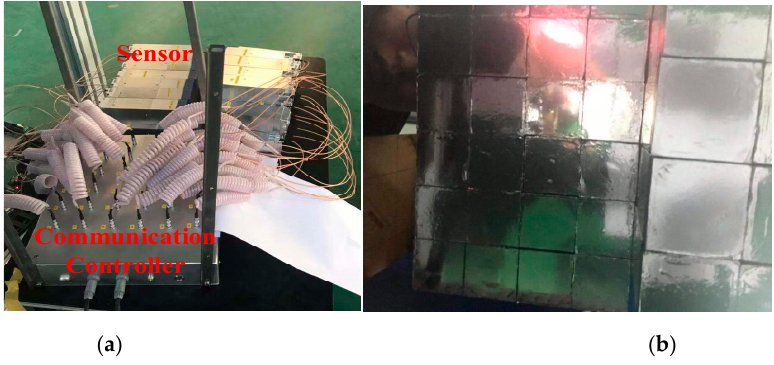
Figure 20. Physical diagram of probe surface and digital communication controller. ( a ) The detector and communication controller. ( b ) The schematic diagram of the detector surface.